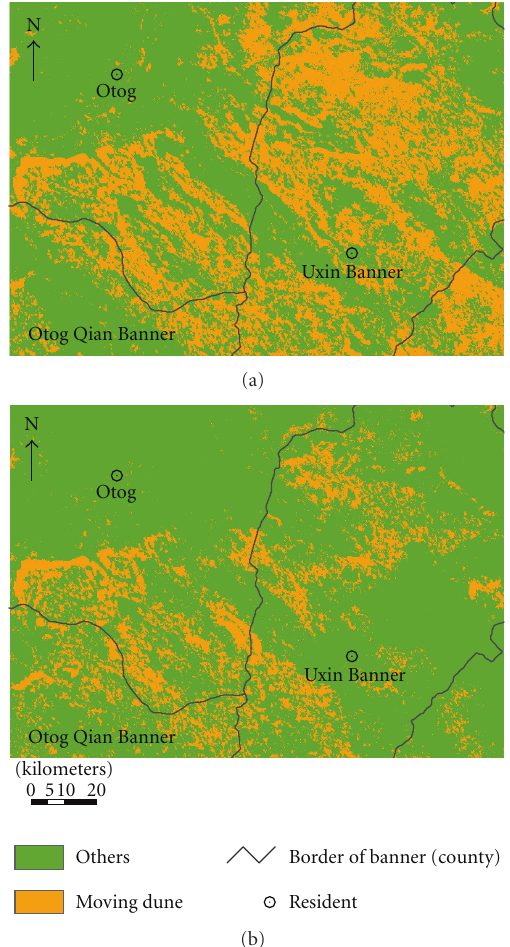
Figure 4: The spatial pattern of moving sand dune in part of Ordos Plateau in 15/09/1988 and 10/07/2010. The area of moving sand dune in 1988 was 6790 km 2 and decreased to 2753 km 2 in